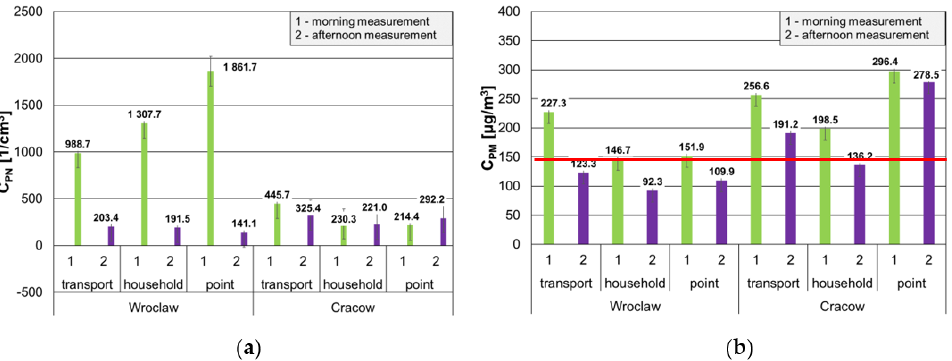
Figure 5. Total average concentration of particle number ( a ) and particulate mass ( b ) in each city (in red line marked alarm level for PM 10 emission settled by Inspectorate of Environmental Protection).